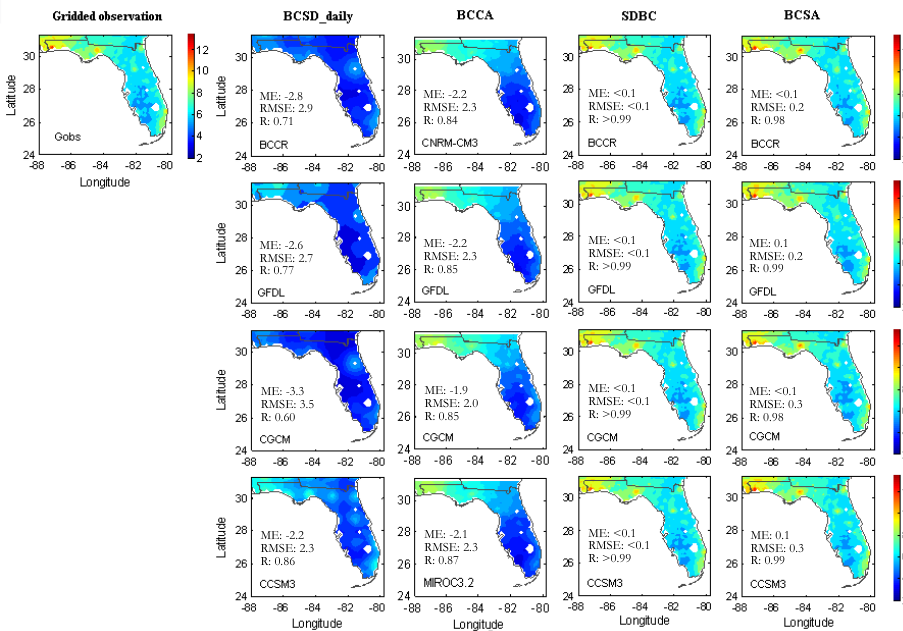
Fig. 7. Spatial distribution of the temporal standard deviation of Gobs, precipitation predictions downscaled using BCSD_daily, BCCA, SDBC, and BCSA for dry season (October through May), units in mm. ME, RMSE, and R are reported on each map for the bias-corrected